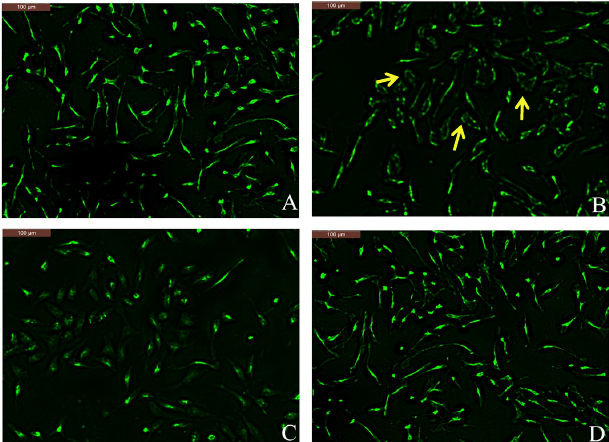
Figure 5. Effects of coptisine on Alexa Fluor-488 phalloidin staining in DNP-IgE/HSA-sensitized cells.